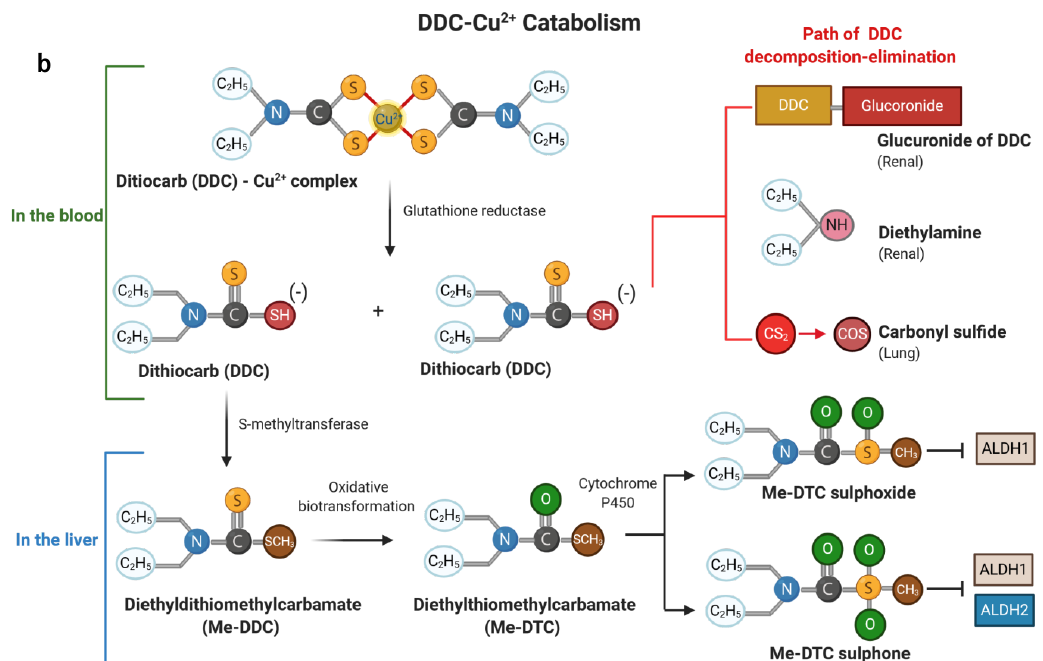
Figure 1. Metabolism of disulfiram (DSF) and its main metabolite diethyldithiocarbamate (DDC). DSF is rapidly hydrolyzed into two molecules of its active metabolite DDC which can complex metal ions like copper (II) ( a ). DDC is further catabolized by several metabolic processes that end up in the inhibition of aldehyde dehydrogenase (ALDH1/2) and different elimination routes ( b ). ALDH oxidizes ethanol to acetaldehyde in the liver and brain, causing a release of high concentrations of histamine, which is responsible for the alcohol flush reaction [4,12,15].